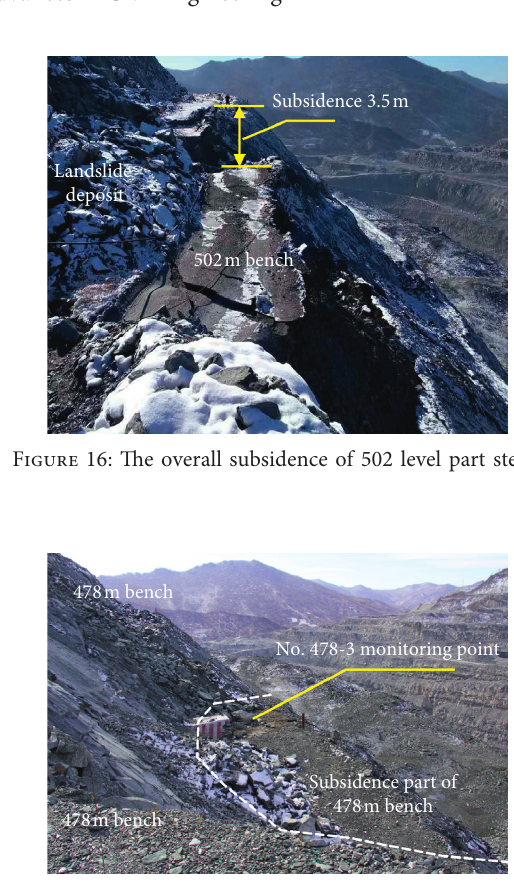
Figure 17: Part of the platform of step 478m slid down to step